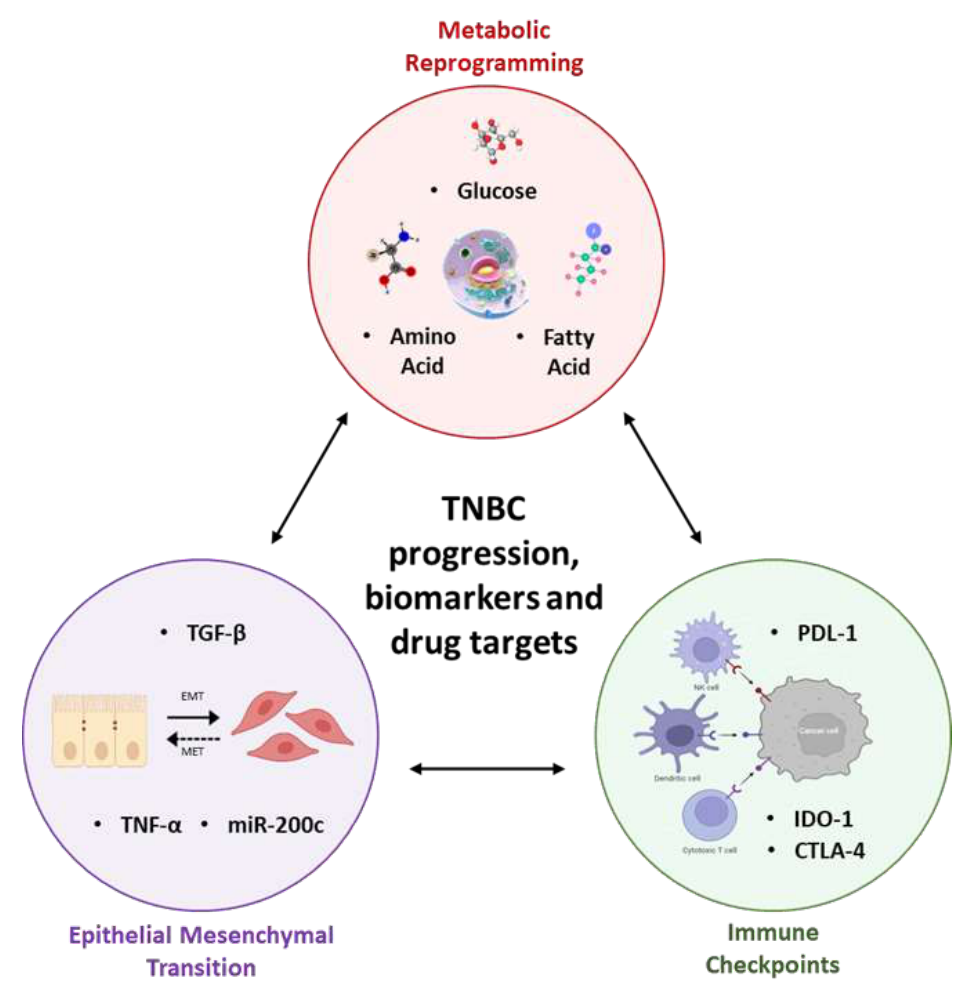
Figure 1. TNBC progression involves interplay of Metabolic Reprogramming, Immune Checkpoints, and Epithelial Mesenchymal Transition.